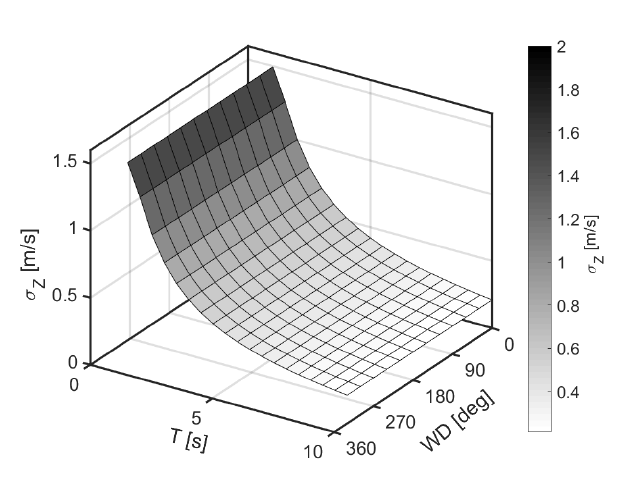
Figure 3. Simulator results of motion-induced HWS error standard deviation, σ Z as a function of motional period, T ( x -axis) and wind direction ( y -axis). HWS is 10 m/s HWS, roll-and-pitch amplitude is 3.5